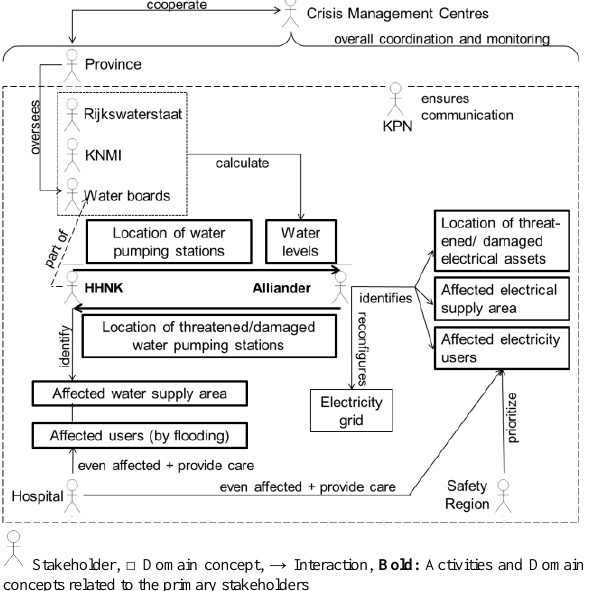
Figure 4. Stakeholders and their roles within crisis